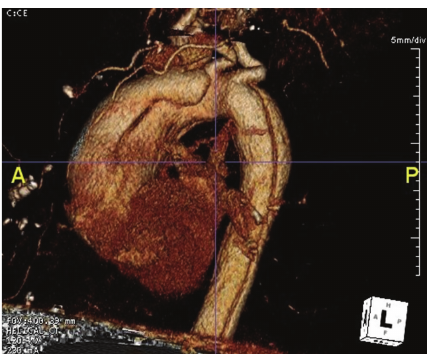
Figure 3: CTA reconstruction demonstrating acute dissection in ascending and descending